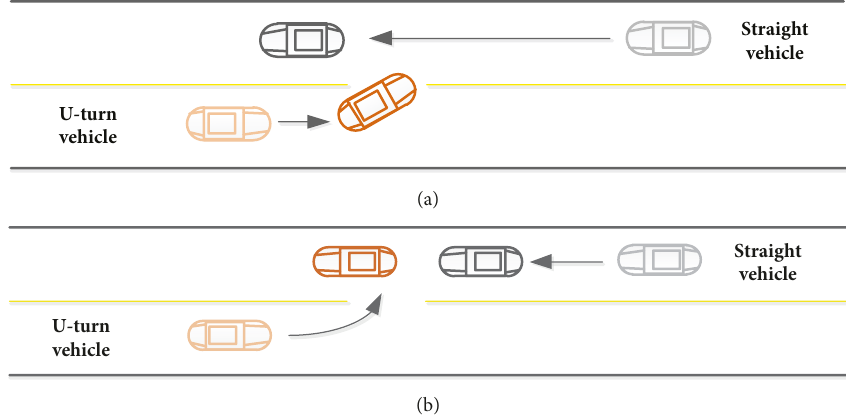
Figure 1: U-turn s cenari o. (a) The U-turn vehicle yields. (b) The straight vehicle